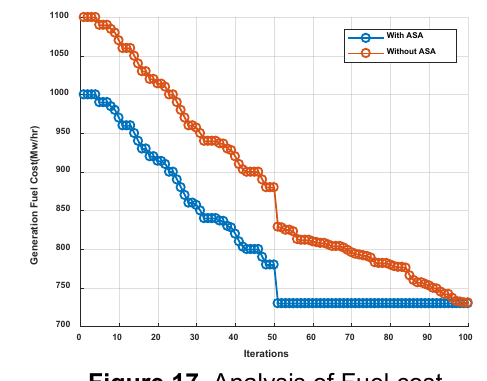
Figure 17. Analysis of Fuel cost